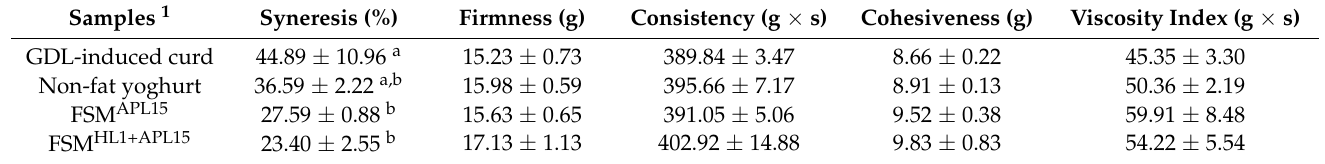
Table 1. Syneresis and texture attributes of the fermented skimmed milk samples at pH 4.50.